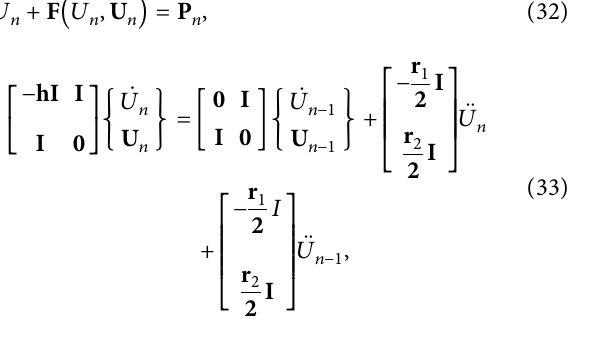
Figure 4: Two types of excitation signal for (a) the bump road inputs, where simulated period T � 4 seconds, sampling interval h � 0.01 second, and vehicle velocity v � 20m/s, and (b) the random road inputs, where simulated period T � 20 seconds, sampling interval h � 0.01 seconds, and vehicle velocity v � 20 m/s.